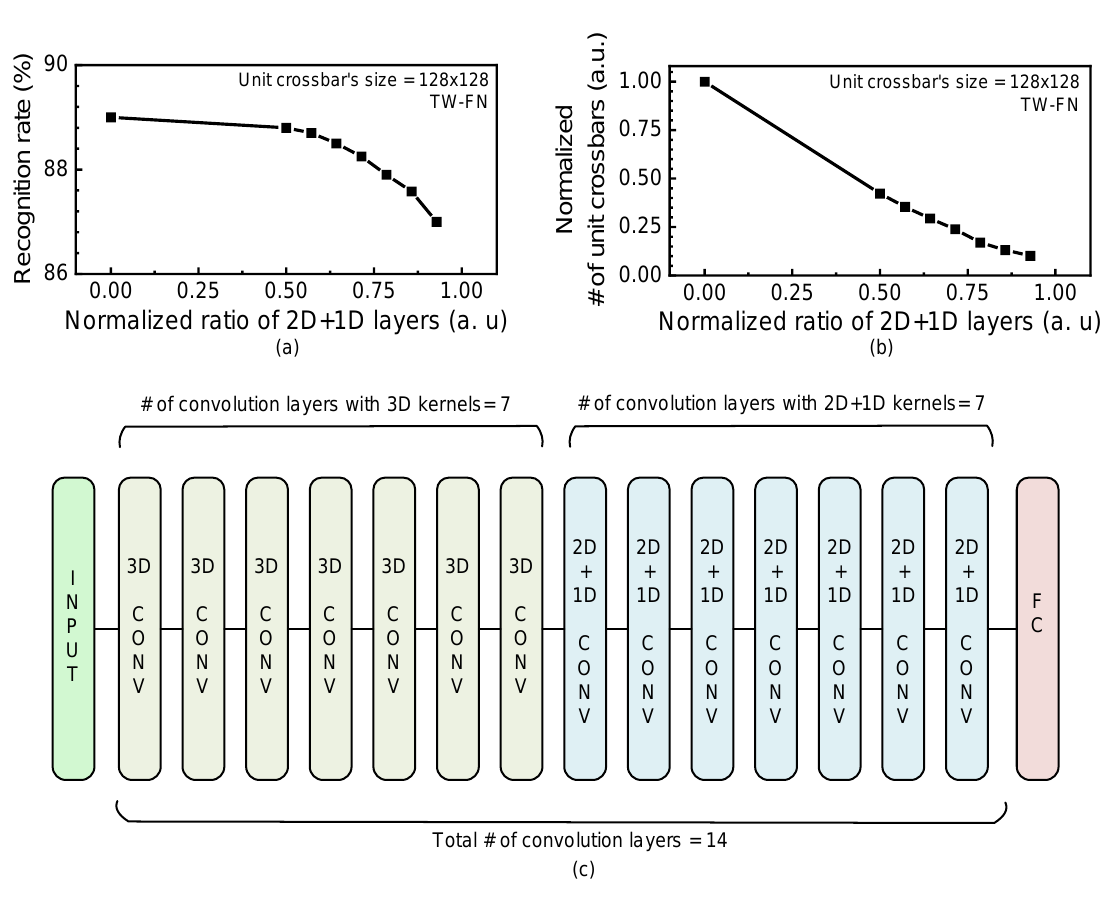
Figure 7. ( a ) The recognition rate with varying the ratio of 2D + 1D convolution layers from 0 to 1. The ratio of convolution layers with 2D + 1D kernels is calculated with the number of 2D + 1D layers divided by the total number of convolution layers. Here, it is assumed that the unit crossbar’s size is 128 × 128 and floating-point neurons and ternary synaptic weights are used in the neural network’s simulation. ( b ) The normalized number of unit crossbars used in the neural networks with varying the ratio of 2D + 1D convolution layers. ( c ) One example of the convolutional neural network’s architecture, when the numbers of 2D + 1D and 3D convolution layers are 7 and 7, respectively, among the total 14 convolution layers. The normalized ratio of 2D + 1D layers in this architecture is 0.5.